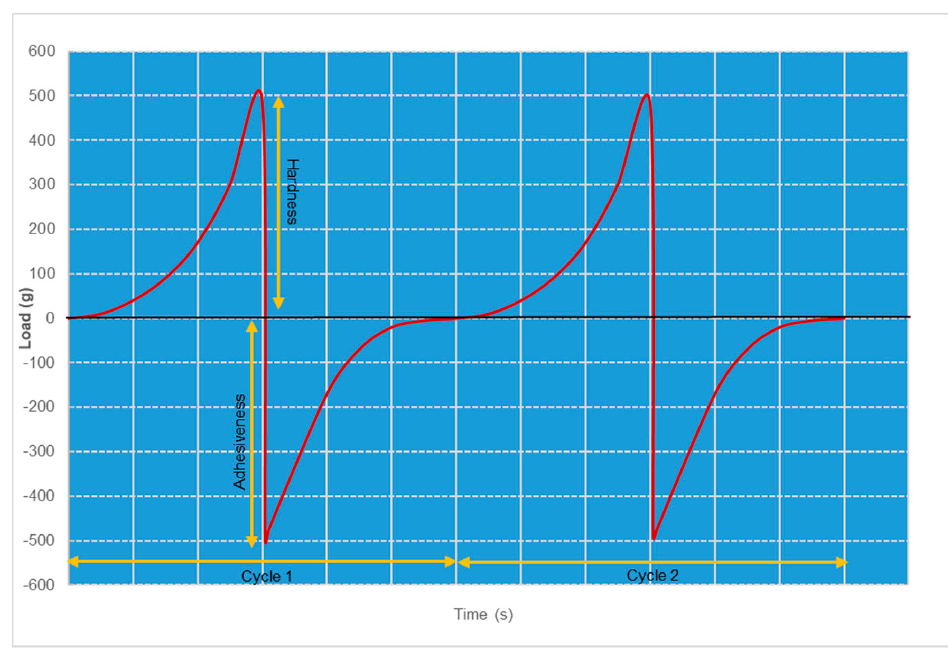
Figure 5. 2 cycles of compression and decompression of the force–time texture profile of chrysin nanoemulgel, determined using texture analyzer.